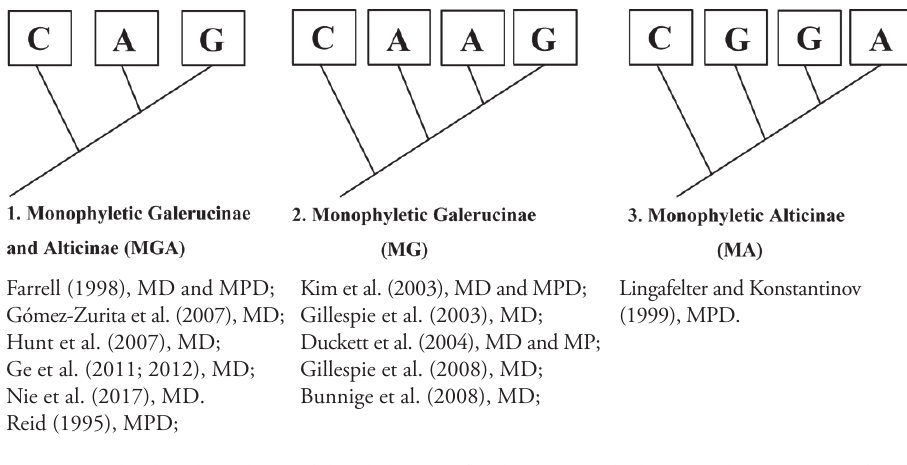
Figure 1. The three hypotheses of the phylogeny of Galerucinae and Alticinae. The supporters of each hypothesis are listed below each. Note: MD = Molecular Data; MPD =